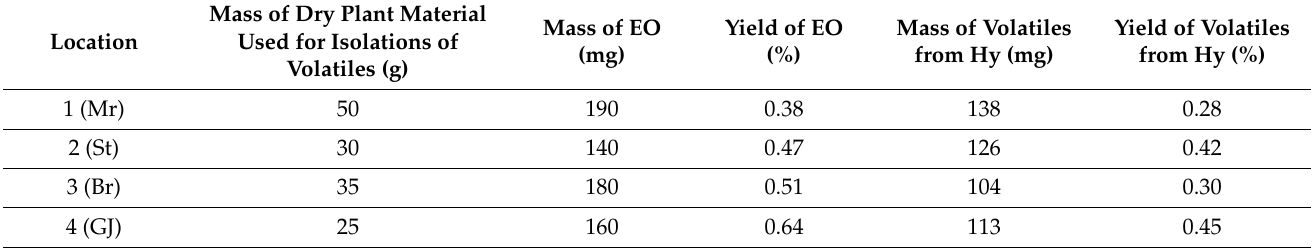
Table 6. Yield of obtained volatile compounds from EOs and